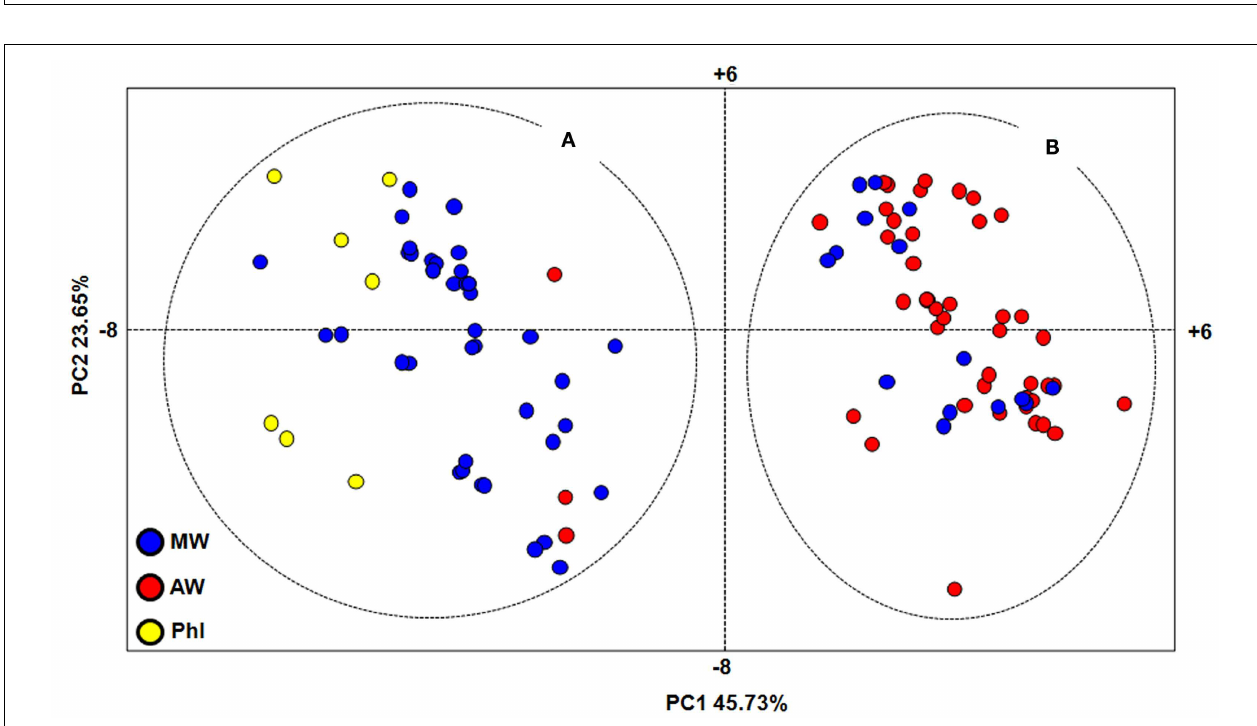
FIGURE 2 | Genetic relationships within the whole set of accessions, as determined by principal component analysis. MW, Mesoamerican wild; AW, Andean wild; PhI, northern Peru and Ecuador.